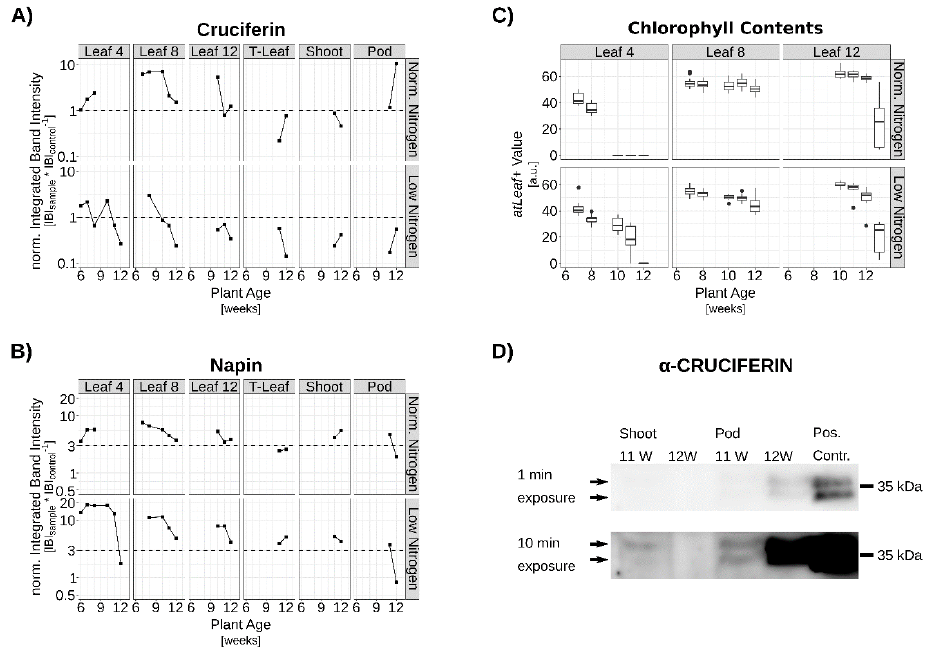
Figure 3. Seed storage protein (SSP) levels of OSR plants grown under normal and limiting nitrogen (N) supply. Quantification of ( A ) CRUCIFERIN and ( B ) NAPIN signals. Material analyzed are samples of 3–5 biological replicates pooled in equal amounts. ( C ) Corresponding chlorophyll contents (median +/ − 1.5xIQR of 3 biological replicates). Upper graphs normal N-supply, lower graphs N-limitation. ( D ) Exemplary signal of stem and pod material detected in a Western blot (marked by arrows, 25 µ g total protein). One min exposure (top) to show non-oversaturated positive control (15 µ g total protein) and 10 min exposure for the shoot and pod signals (bottom).